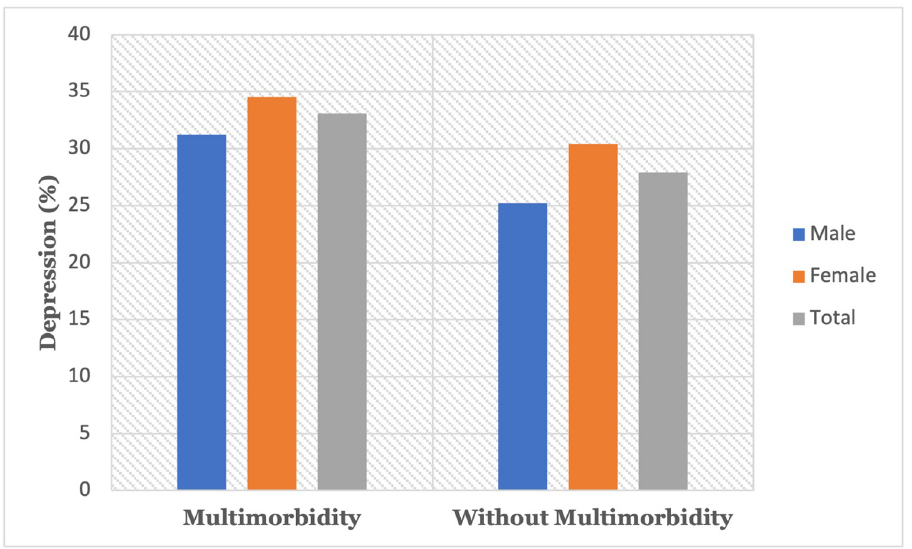
Fig 2. Prevalence of depression across the multimorbidity status in older